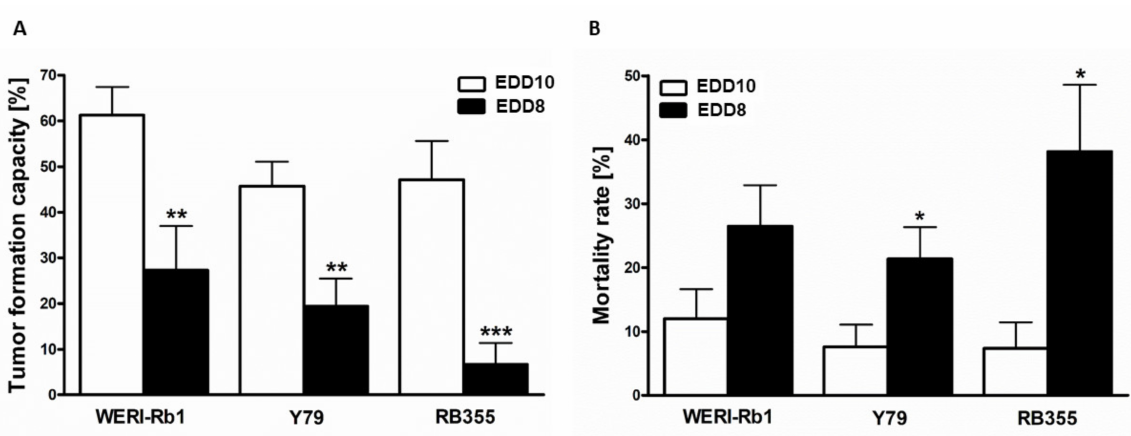
Figure 5. Effects of different inoculation time points on tumor formation capacity and chicken mortality in ovo. Tumor formation capacity of all three RB cell lines (WERI-Rb1, Y79 and RB355) is significantly decreased upon inoculation at embryonic development day eight (EDD8) in comparison to embryonic development day ten (EDD10) ( A ). The mortality rate of the chicken embryos was increased for all RB cell lines after inoculation on EDD8 in comparison to EDD10 ( B ). Values are means of three independent experiments ± SEM. * p < 0.05, ** p < 0.01, *** p < 0.001; statistical differences calculated by Student’s t